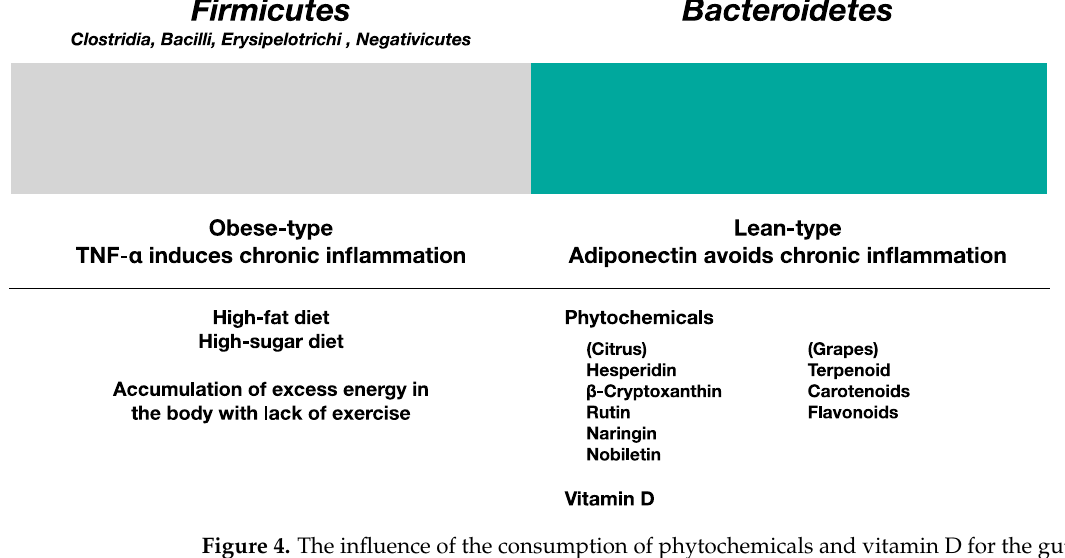
Figure 4. The influence of the consumption of phytochemicals and vitamin D for the gut microbiota. High-fat, high-sugar, high-calorie diet is responsible for obesity; these conditions lead to metabolic syndrome due to the lack of exercise. This status causes chronic inflammation induced by pathogenic contributor TNF- α , and the state of microbiota becomes Firmicutes dominant. On the other hand, the intake of phytochemicals and vitamin D preferentially induces beneficial gut microbiota with increasing protector adiponectin. Mainly the increase of Bacteroidetes and the decrease of the F/B ratio is bene fi cial for maintaining a healthy condition.